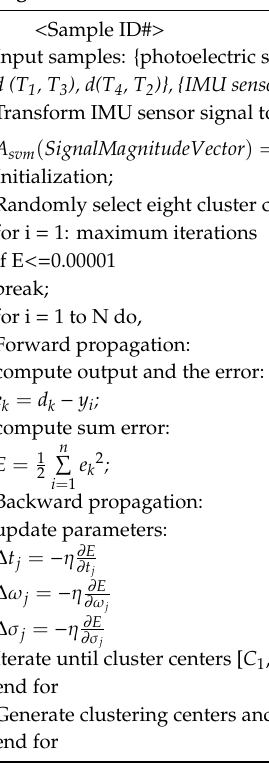
Algorithm 1: SVM-RBF-KNN